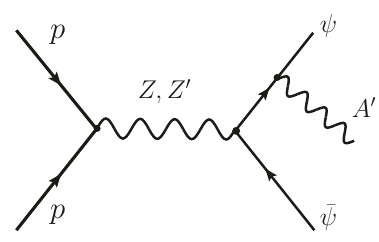
Figure 3 . Feynman diagram for the dark photon production at the